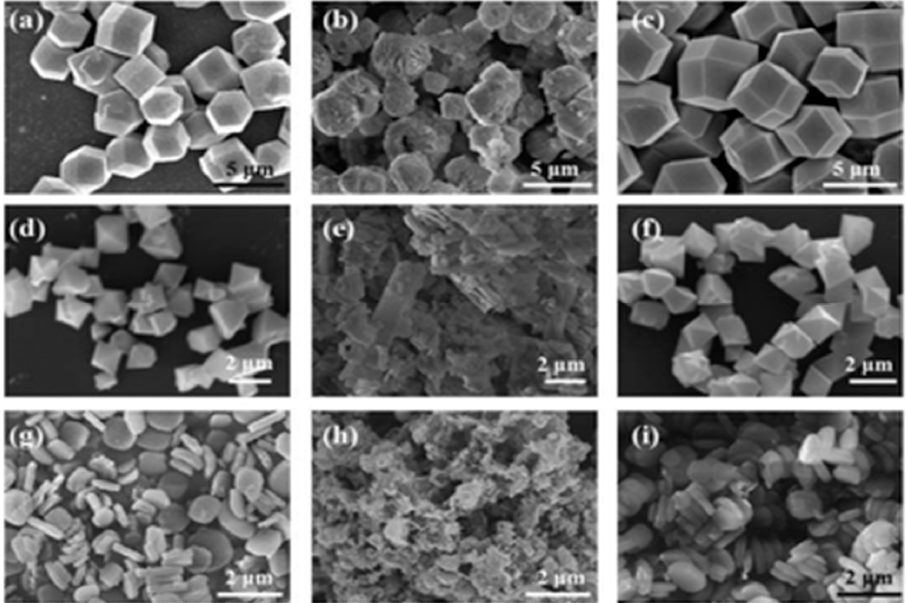
Figure 8. SEM images of ( a ) the AS ZIF-67, ( b , c ) the AS ZIF-67 and SH ZIF-67 after exposure to water for 5 days, respectively, ( d ) the AS HKUST-1, ( e , f ) the AS HKUST-1 and SH HKUST-1 after exposure to water for 5 days, respectively, ( g ) the AS NH 2 -MIL-125(Ti), ( h , i ) the AS NH 2 -MIL-125(Ti) and SH NH 2 -MIL-125(Ti) after exposure to water for 5 days, respectively. Reprinted with permission [66] Copyright 2017, Royal Society of Chemistry.